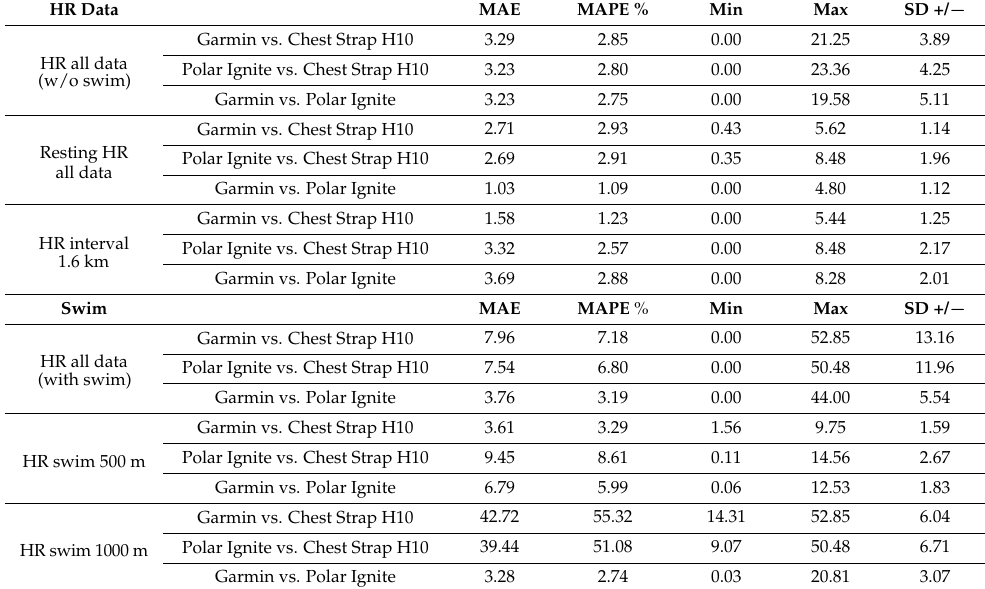
Table 1. Heart rate measurement deviation calculation, mean absolute error, mean absolute percent- age error ( n =